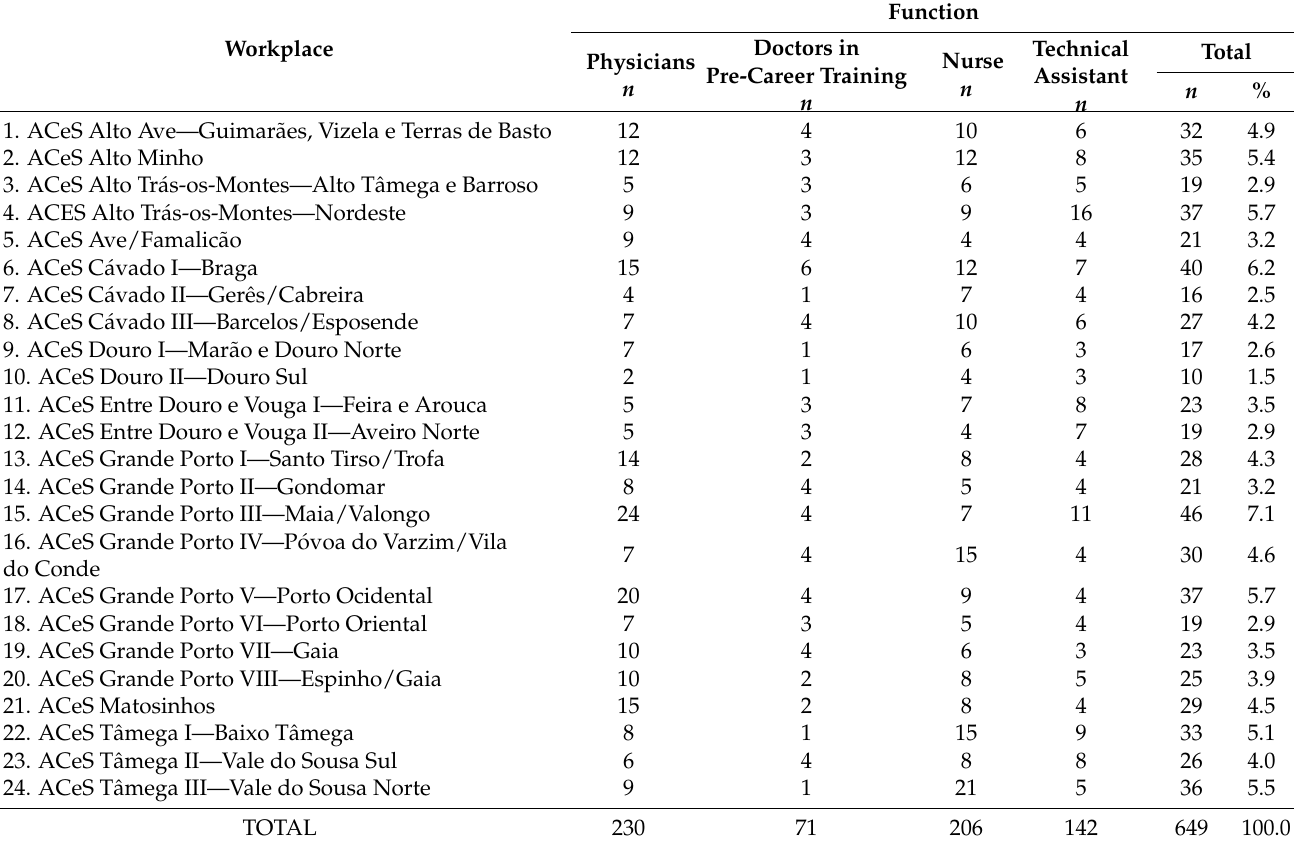
Table 1. Descriptive analysis of the sample: workplace and function